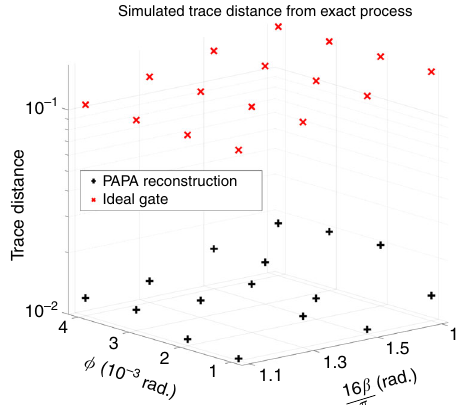
Fig. 4 Cross resonance gate simulations. Simulated trace distance between the three-qubit Choi state for the simulated CR-CNOT with coherent error and either the PAPA reconstructed Choi state (black + ) or the ideal gate (red ×), as a function of over-rotation error (angle β ) and stray ZZ -coupling (angle ϕ ), see